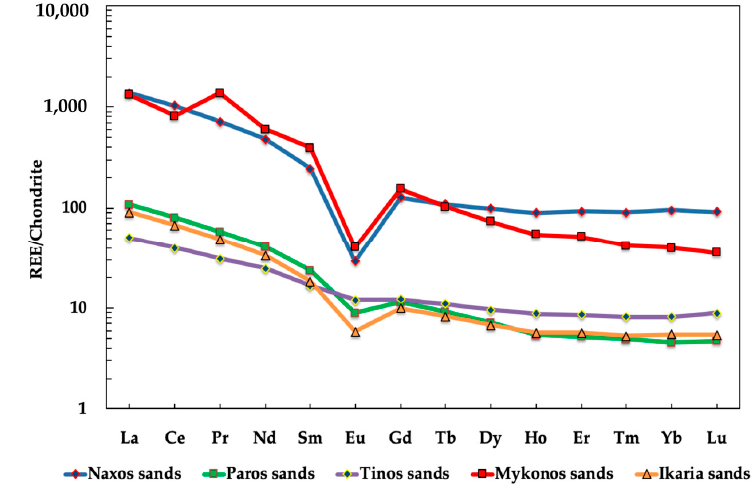
Figure 8. Chondrite-normalized patterns of REE for coastal sands derived from different localities in the Atticocycladic zone (Mykonos, Serifos, Naxos, Ikaria, Tinos, Paros). According to Papadopoulos et al. [64], the geochemical comparison between the source rocks Minerals 2019 , 9 , x FOR PEER REVIEW and the coastal sands of the Atticocycladic coastal zone show a clear source-to-sink control for the REE budgets (Figure 9). Among the heavy minerals present, allanite is the dominant REE-phase and thus controls the bulk REE signature. Xenotime, thorite, and monazite—being non-silicate minerals and thus relatively easier to extract REEs from their mineral structures—have also been identified, but they are found in relatively small concentrations (Figure 10). Allanite from both the source granitoids and coastal sands of Mykonos have similar characteristics (e.g., zonation and composition), confirming the source control. An igneous and metamorphic origin though is suggested for allanite that is present in the samples from Naxos [64].